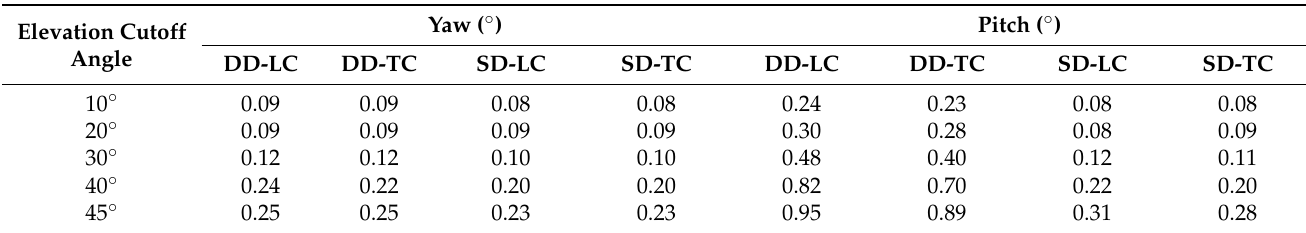
Table 10. The yaw and pitch RMS errors of the DD-LC, DD-TC, SD-LC, and SD-TC models under different elevation cutoff angles in the multi-epoch